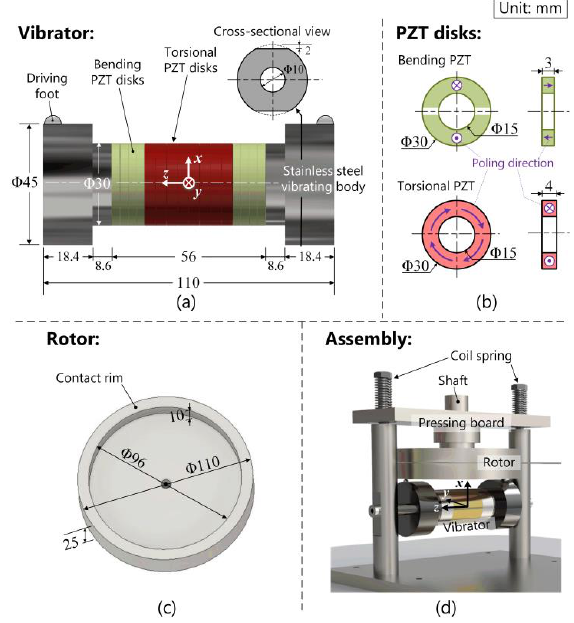
Figure 1. Schematic of the T/F motor. ( a ) The transducer’s configuration, ( b ) poling direction of flexural and torsional PZT disks, ( c ) the rotor’s structure, and ( d ) the assembly. A Cartesian coordinate ( x , y , and z axes) is built on the middle surface of the transducer. (30 mm in outer diameter, 15 mm in inner diameter, and 3 mm in thickness) were divided into two parts with opposite poling directions, while the torsional ones (30 mm in outer diameter, 15 mm in inner diameter, and 4 mm in thickness) were poled in the circumferential direction. The PZT disks were clamped between the vibrating bodies with a stainless-steel screw. (2) Arrange the PZT disks. Since the motor works in the 1st-order torsional and the 1st-order flexural modes, the torsional PZT disks were set in the middle part of the vibrator. Additionally, the central position of the flexural PZT disks located at the node of the flexural mode. By solving the Equation [21]: